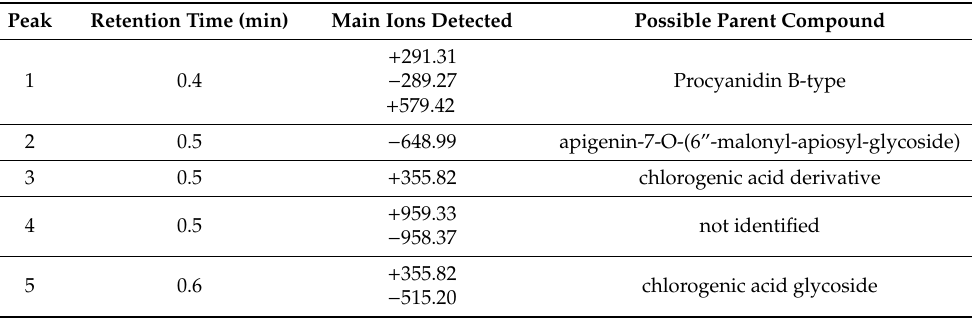
Table 2. HPLC-MS analysis of cooked Borlotti bean